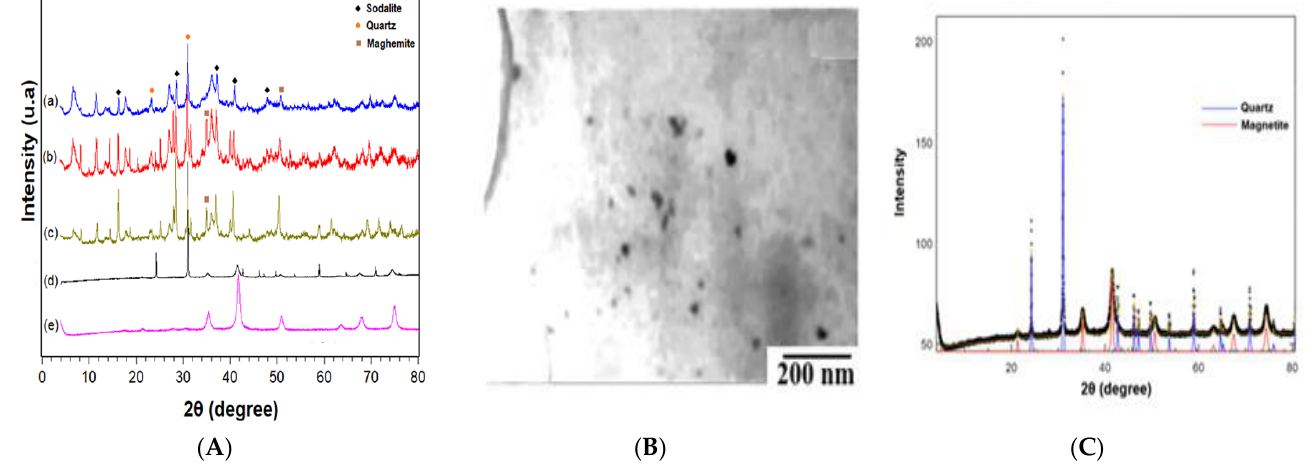
Figure 3. X-Ray diffraction ( A ): (a) geopolymer wt 3%; (b) geopolymer wt 2%; (c) geopolymer wt 1%; (d) magnetic nanoparticles; (e) magnetite. ( B ) TEM of the magnetite and ( C ) Full Profile Search Match quantification quartz and magnetite.